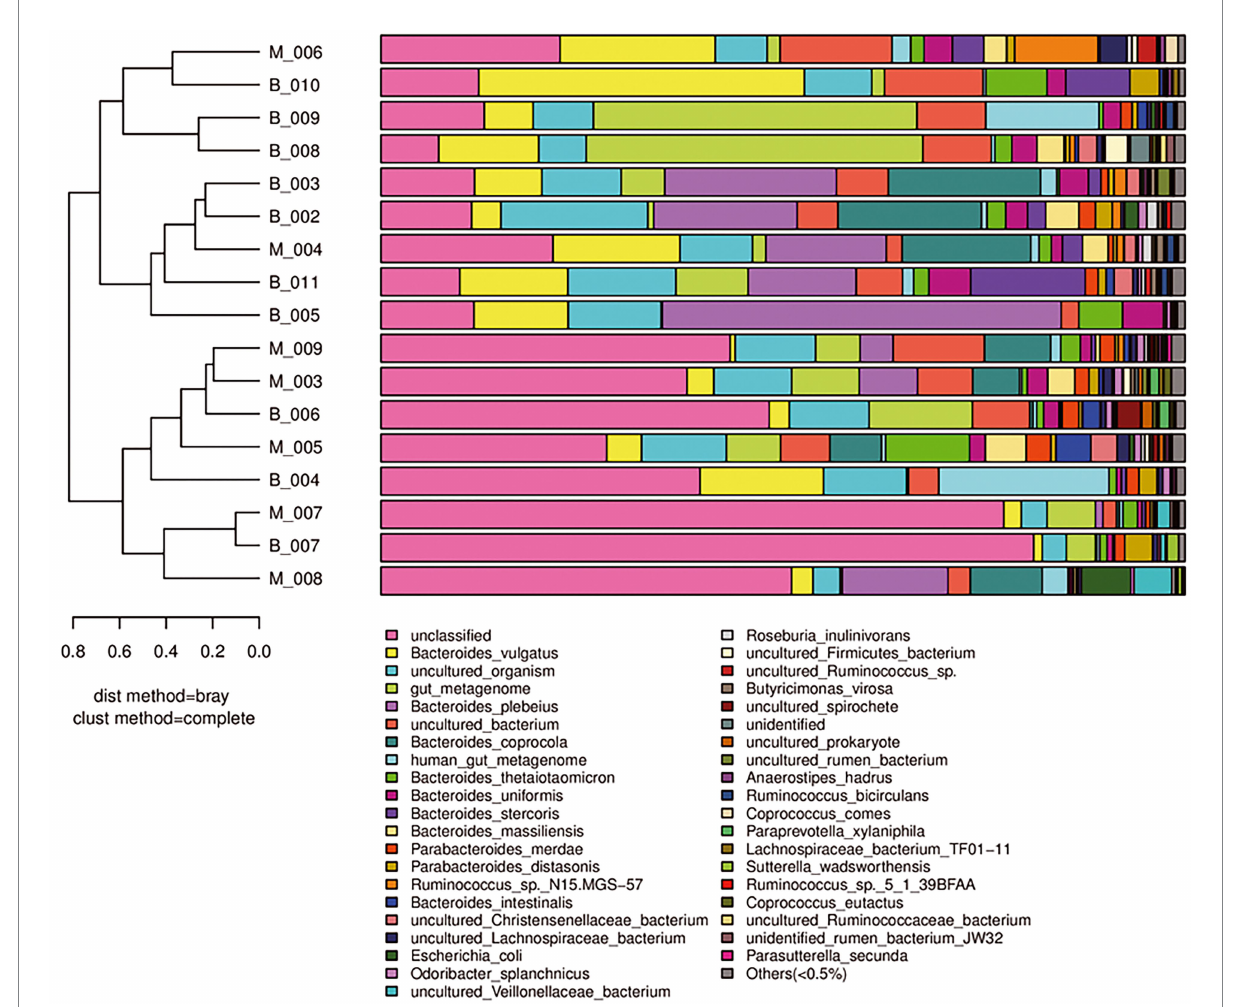
β -Diversity analysis of Group M and Group B. A sample clustering tree and histogram combination analysis diagram at the species level is shown. The left side shows a hierarchical clustering analysis between samples based on community composition. The two groups of samples show the phenomenon of convergence in the same group. The right side shows a histogram of a community structure of the corresponding